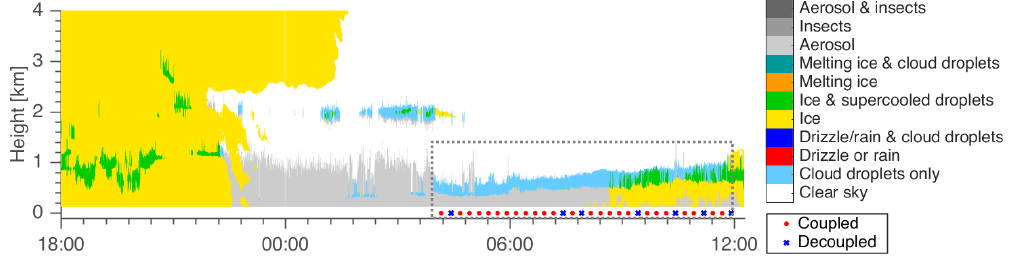
Figure 2. Example of the Cloudnet target classification product from 29 May, 18:00UTC to 30 May 2018, 12:00UTC. For the P-MPC, indicated by the gray dashed box, the time series of coupling is also shown. This case was classified as